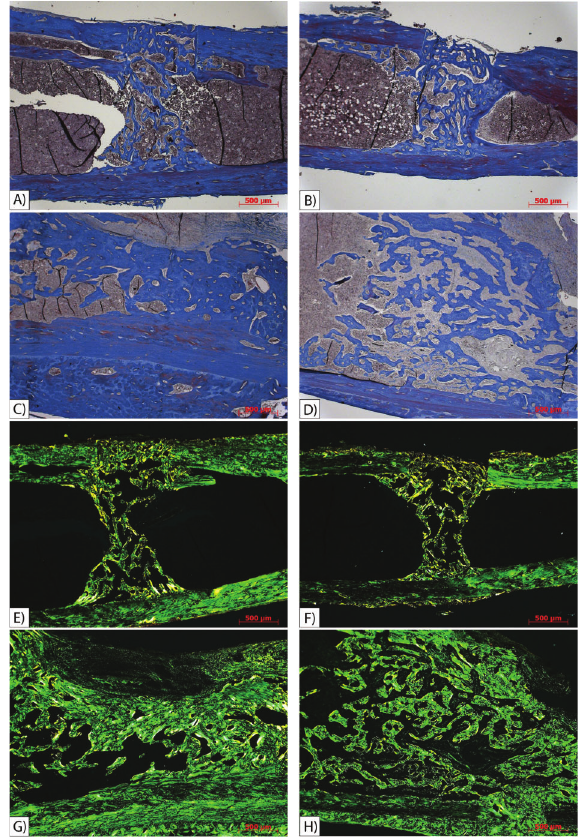
Figure 3. Histological photomicrography of tibia sections stained by Trichrome Masson ( A-D ) and Picro-Sirus Red ( E-H ), original magni fi cation 50 (cid:1) . Group OU2 ( A ) and group OS2 ( B ) showed lower amounts of bone formation than group OU6 ( C ) and group OS6 ( D ). Group OU2 ( E ) and group OS2 ( F ) showed lower collagen levels than group OU6 ( G ) and group OS6 ( H ). Group OU2: unrestricted rats 2 weeks post-osteotomy; group OS2: suspended rats 2 weeks post-osteotomy; group OU6: unrestricted rats 6 weeks post-osteotomy; group OS6: suspended rats 6 weeks post-osteotomy.